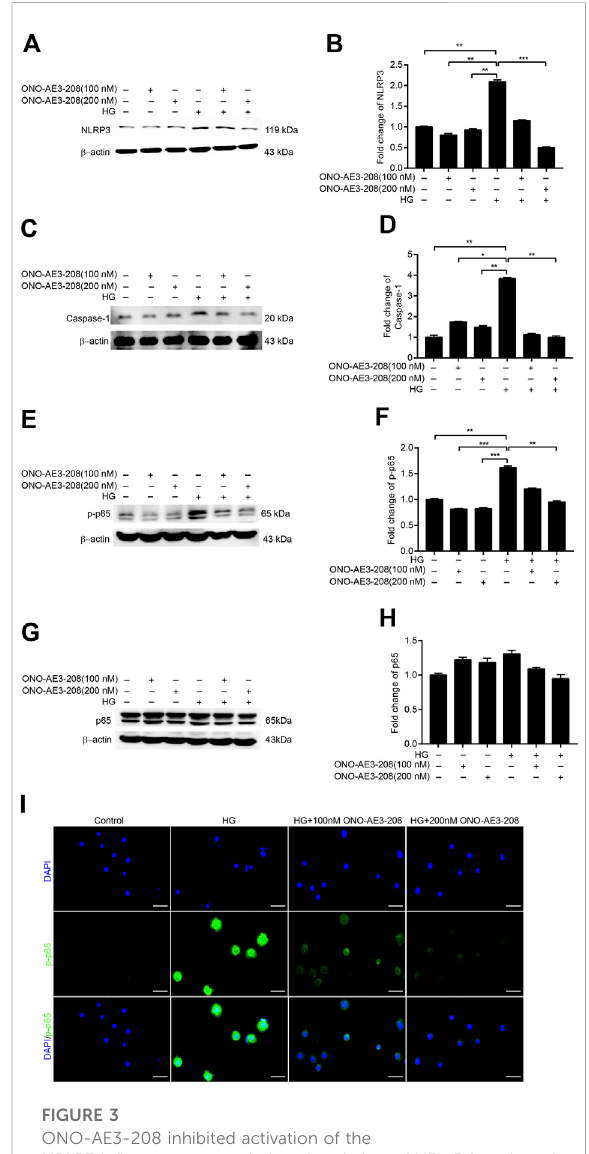
FIGURE 3 ONO-AE3-208 inhibited activation of